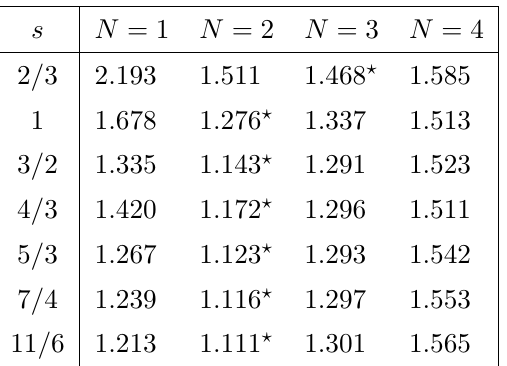
Table 1 . The function F ( N ) /N determining which solution has the smallest energy per N as function of N at LO. The smallest number is marked with a ? . Except for s = 2 has the smallest energy at LO, all the cases have the smallest energy at LO for N = 2